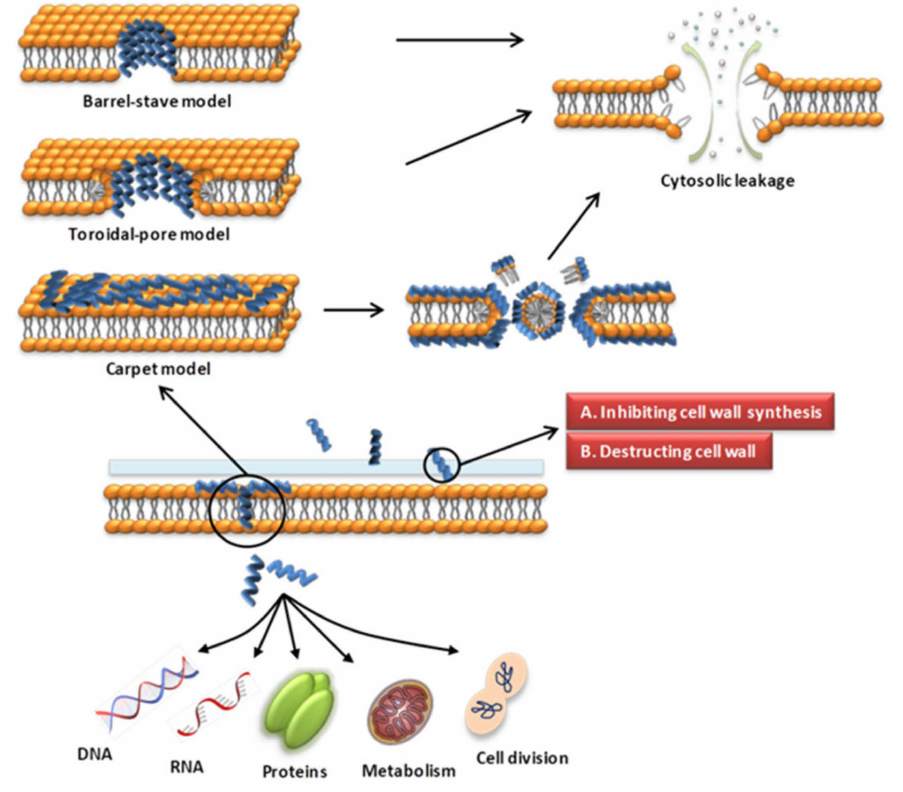
Figure 1. Schematic presentation of the antibacterial mechanism of AMPs. Some AMPs act on cell membranes through different modes of action, increasing membrane permeability, leading to leakage of cell contents and cell death. Modes of action include barrel-stave, toroidal-pore, carpet models. Some AMPs act on the cell wall and exert antibacterial effects by affecting the synthesis of cell wall components and destroying the cell wall structure. Some AMPs enter the cell through direct penetration or endocytosis, and exert anti-microbial effects by targeting the nucleus, organelles, present in fungi, or intracellular